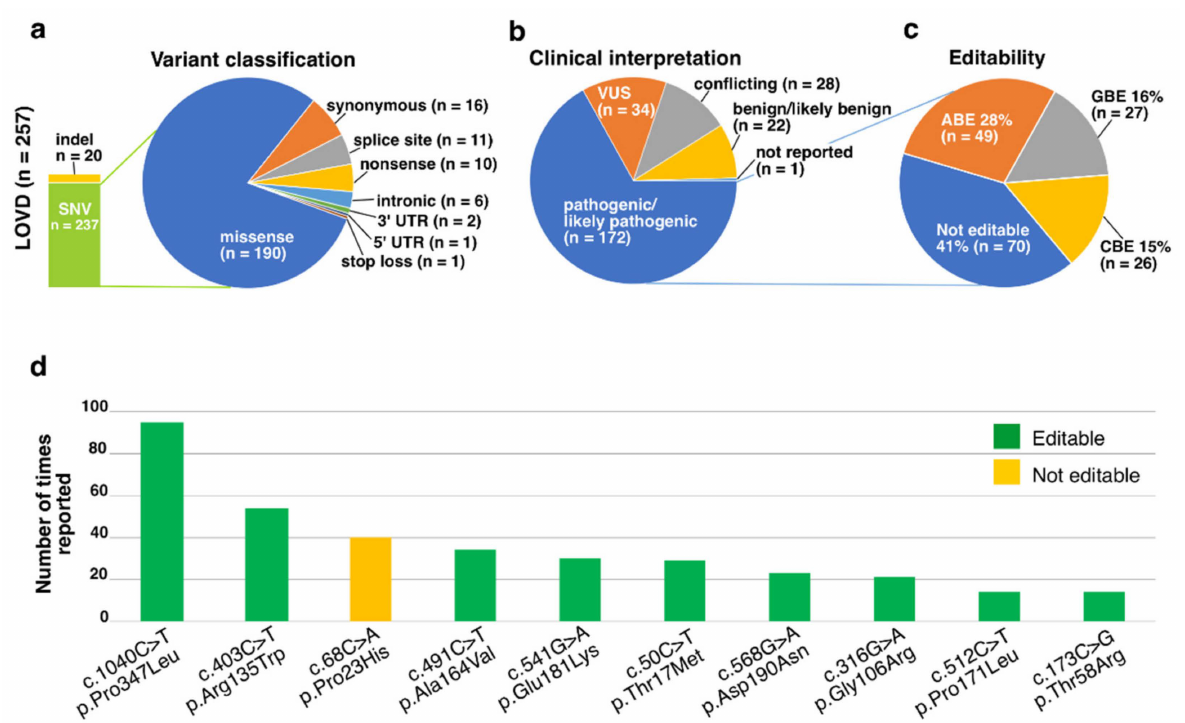
Figure 2. Graphical illustration of the LOVD dataset. ( a ) RHO variants from altogether 906 individuals have been reported to the LOVD, comprising 257 unique variants. The most common variant type was missense variant, which covered over 80% of all the reported unique SNVs. ( b ) Clinical interpretation was reported for all but one of the variants, and 67% were labeled as pathogenic or likely pathogenic. ( c ) Of the pathogenic or likely pathogenic variants, 59% could be edited with ABE, CBE or GBE, with ABE being the most frequently usable base editor. ( d ) Ten most frequently reported RHO variants in the LOVD dataset were all associated with disease, and together accounted for 39% of all the dataset entries. Only one of these variants, the c.68C>A, p.Pro23His, is not editable with current base